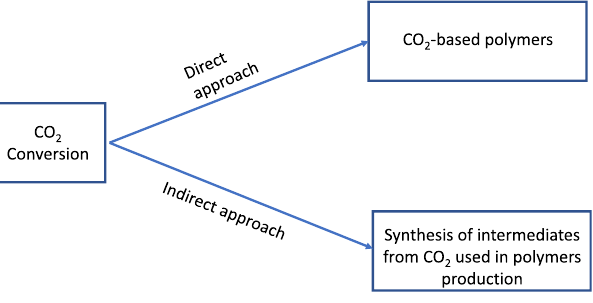
Fig. 2. Approaches for CO 2 conversion into chemicals/ polymers.